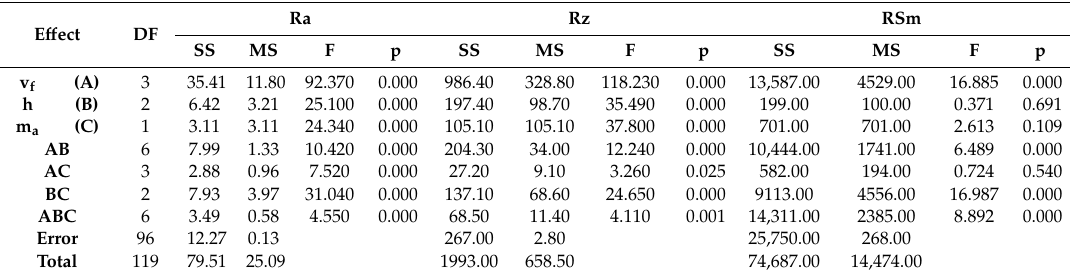
Table 5. Analysis of variance (ANOVA) for di ff erent roughness parameters—Ra, Rz, and RSm (AlSi10Mg alloy). Ra E ff ect DF